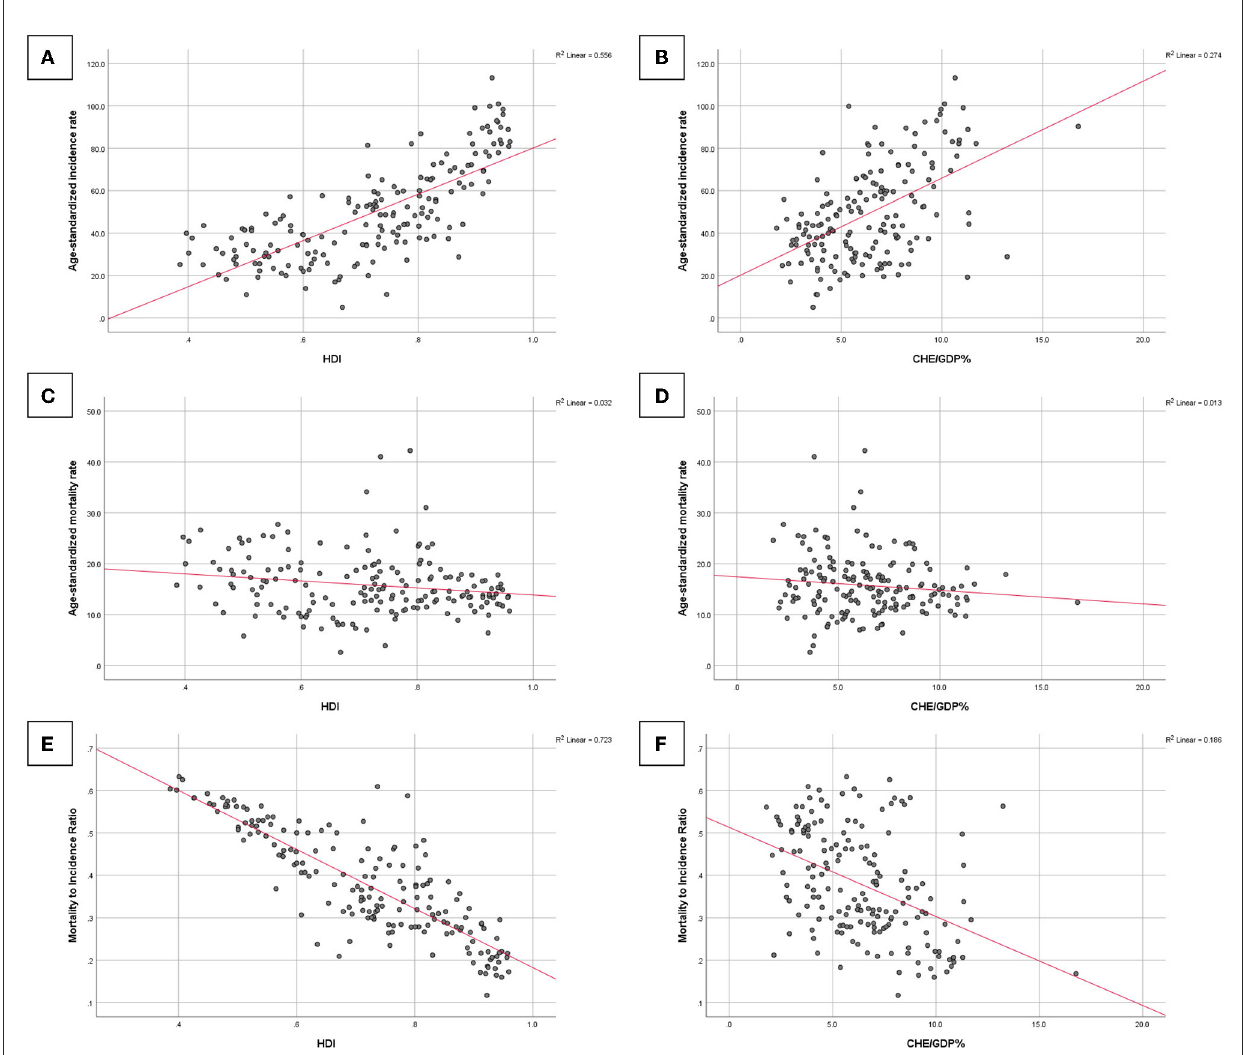
FIGURE3 Associations of BC age-standardized incidence rate with (A) the human development index (HDI) and (B) the current healthcare expenditure to gross domestic product (CHE/GDP%), BC ASMR with (C) HDI and (D) CHE/GDP%, and BC MIR with (E) HDI and (F)